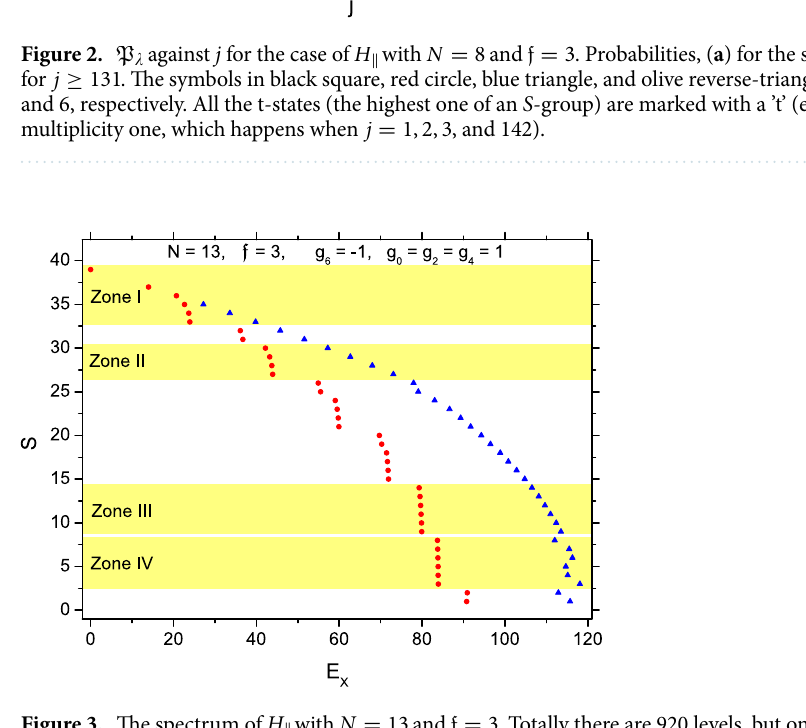
Figure 3. The spectrum of H (cid:31) with N = 13 and f = 3 . Totally there are 920 levels, but only the excitation energies of the b- and t-states of every S -group are marked (refer to Fig.